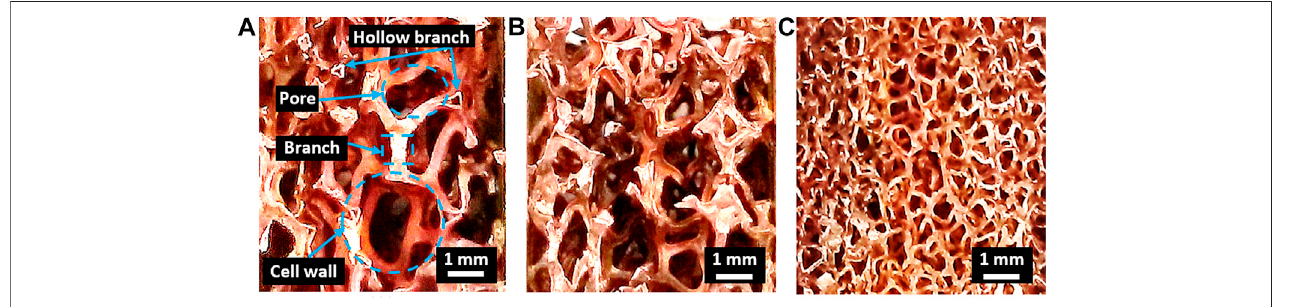
FIGURE 1 | Cu foam macrostructure (A) foam A, (B) foam b, and (C) foam C.